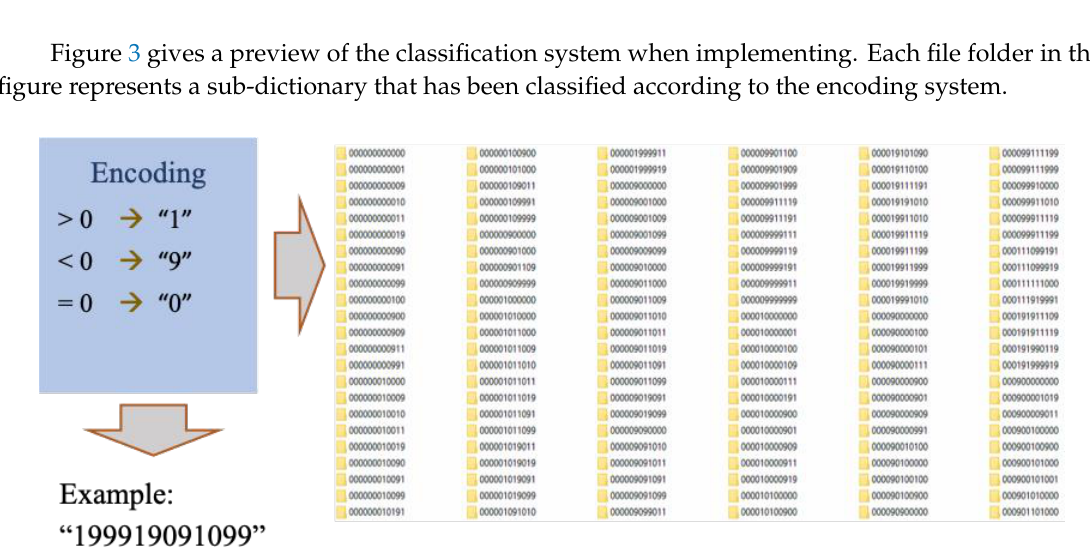
Table 7. The sub-dictionary loose indexing algorithm.